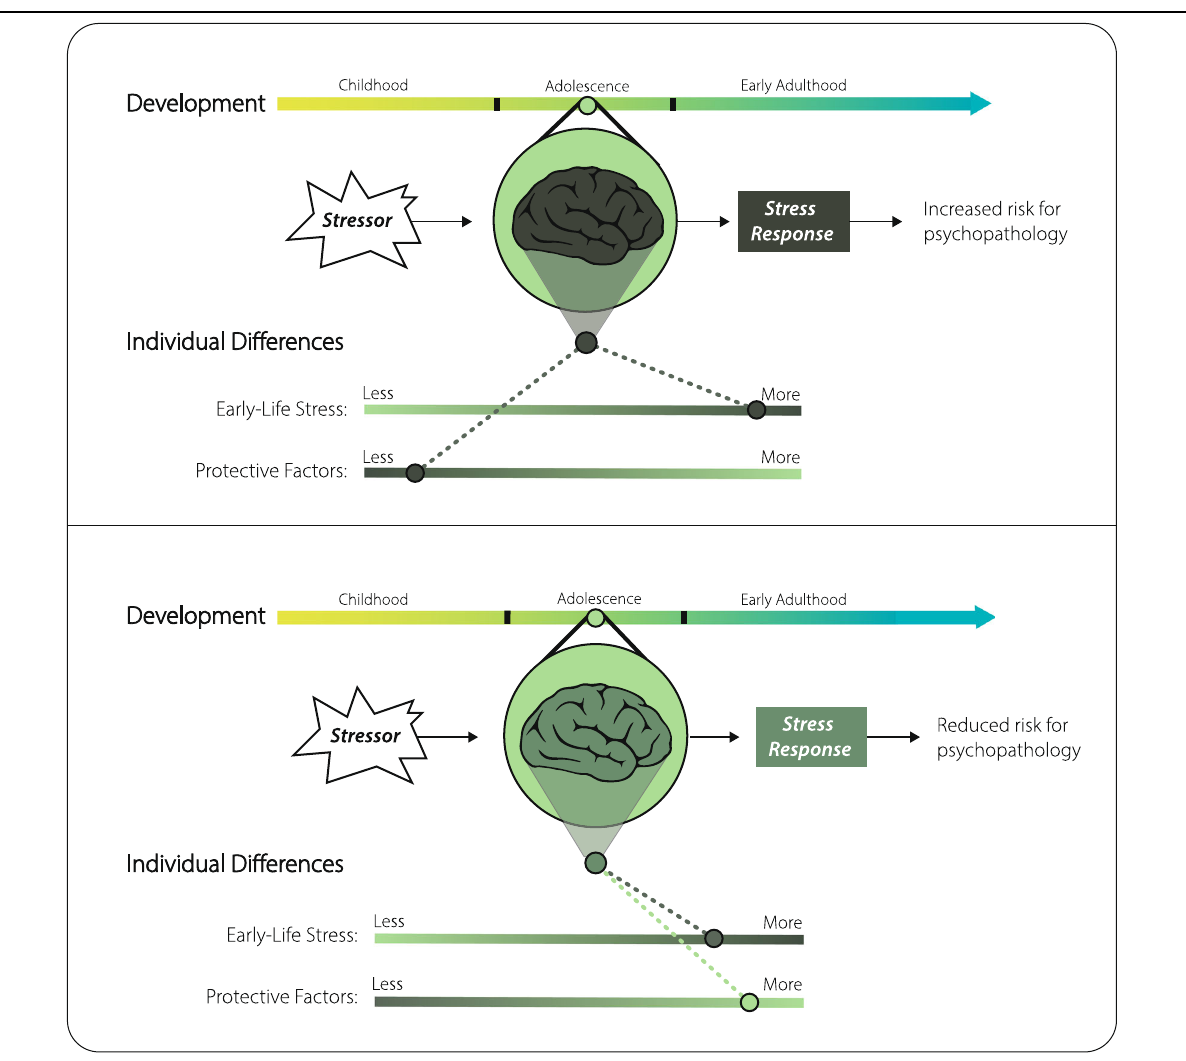
Fig. 2| Developmentalstageand individualpro fi leofearly-lifestressexposure and protectivefactors shape stressresponseand mentalhealth in the context ofa stressor. The general framework of developmental and individual differences in stress responding can be applied fl exibly to many speci fi cs of developmental timing and individual factors. Here we illustrate one example of variability in exposuretoearly-lifestressandprotectivefactors(e.g.,supportivecaregiving).For